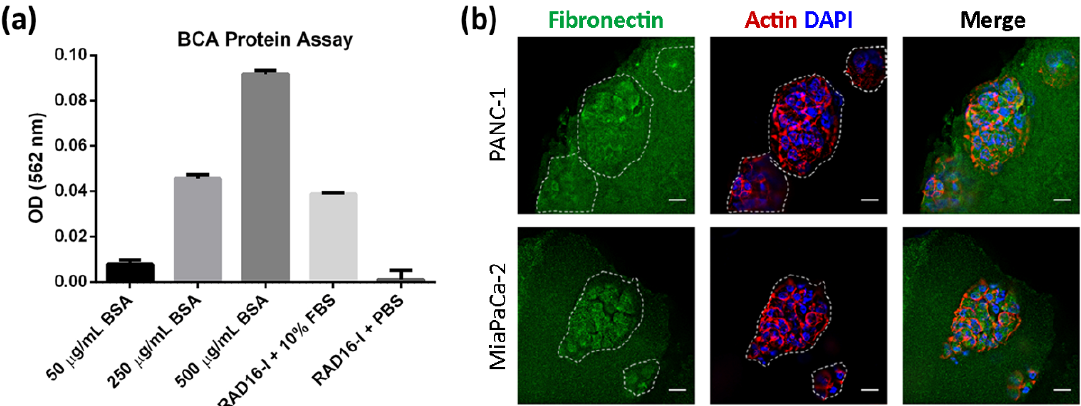
Figure 2. Protein adsorbing into RAD16-I hydrogels. ( a ) BCA protein assay of RAD16-I gels. The graph shows the OD values obtained for known concentrations of protein (50 µg/mL − 500 µg/mL BSA) and RAD16-I hydrogels assembled with 10% FBS or PBS; ( b ) fibronectin (green) immunofluorescence of PANC-1 and MiaPaCa-2 cells in RAD16-I 3D culture counterstained with phalloidin (red) and DAPI (blue). Scale bars represent 20 µm.